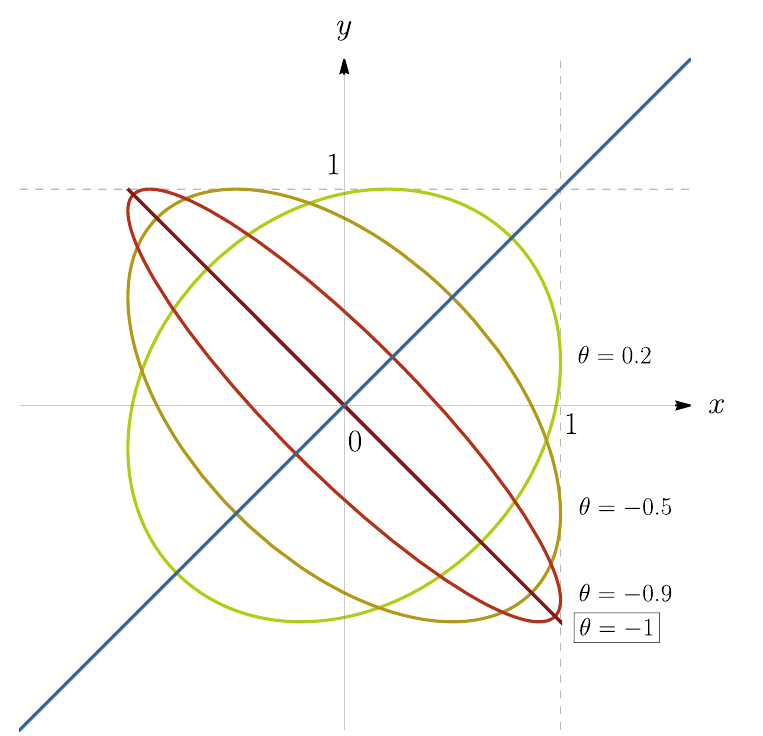
Figure 10 . Various colored ellipses (Brown for θ = − 1 , Red for θ = − 0 . 9 , Yellow for θ = − 0 . 5 and Green for θ = 0 . 2 ) represents the contour for ρ 2 = 0 for various θ including a special case θ = 0 . Blue line represents parameter space for configuration (2.1).